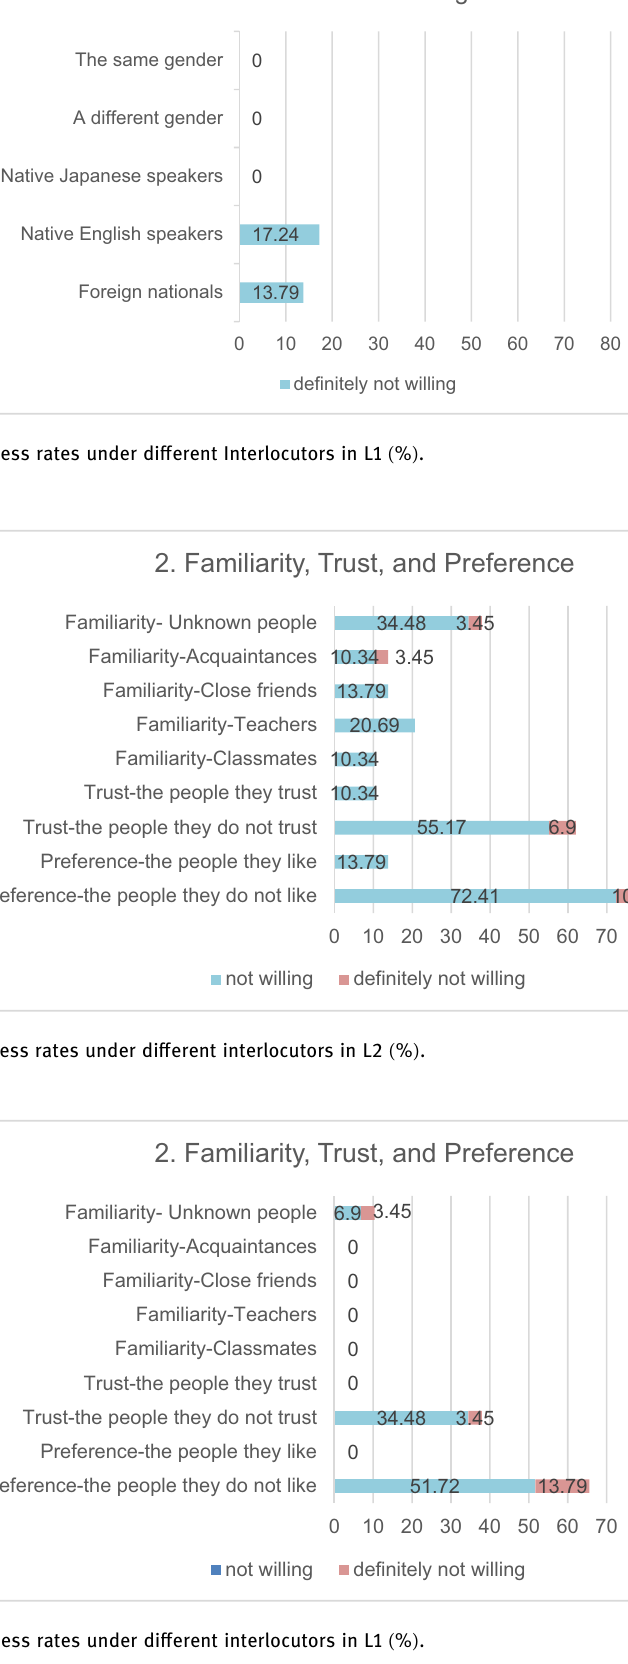
Figure 16: Unwillingness rates under di ff erent interlocutors in L1 ( % )